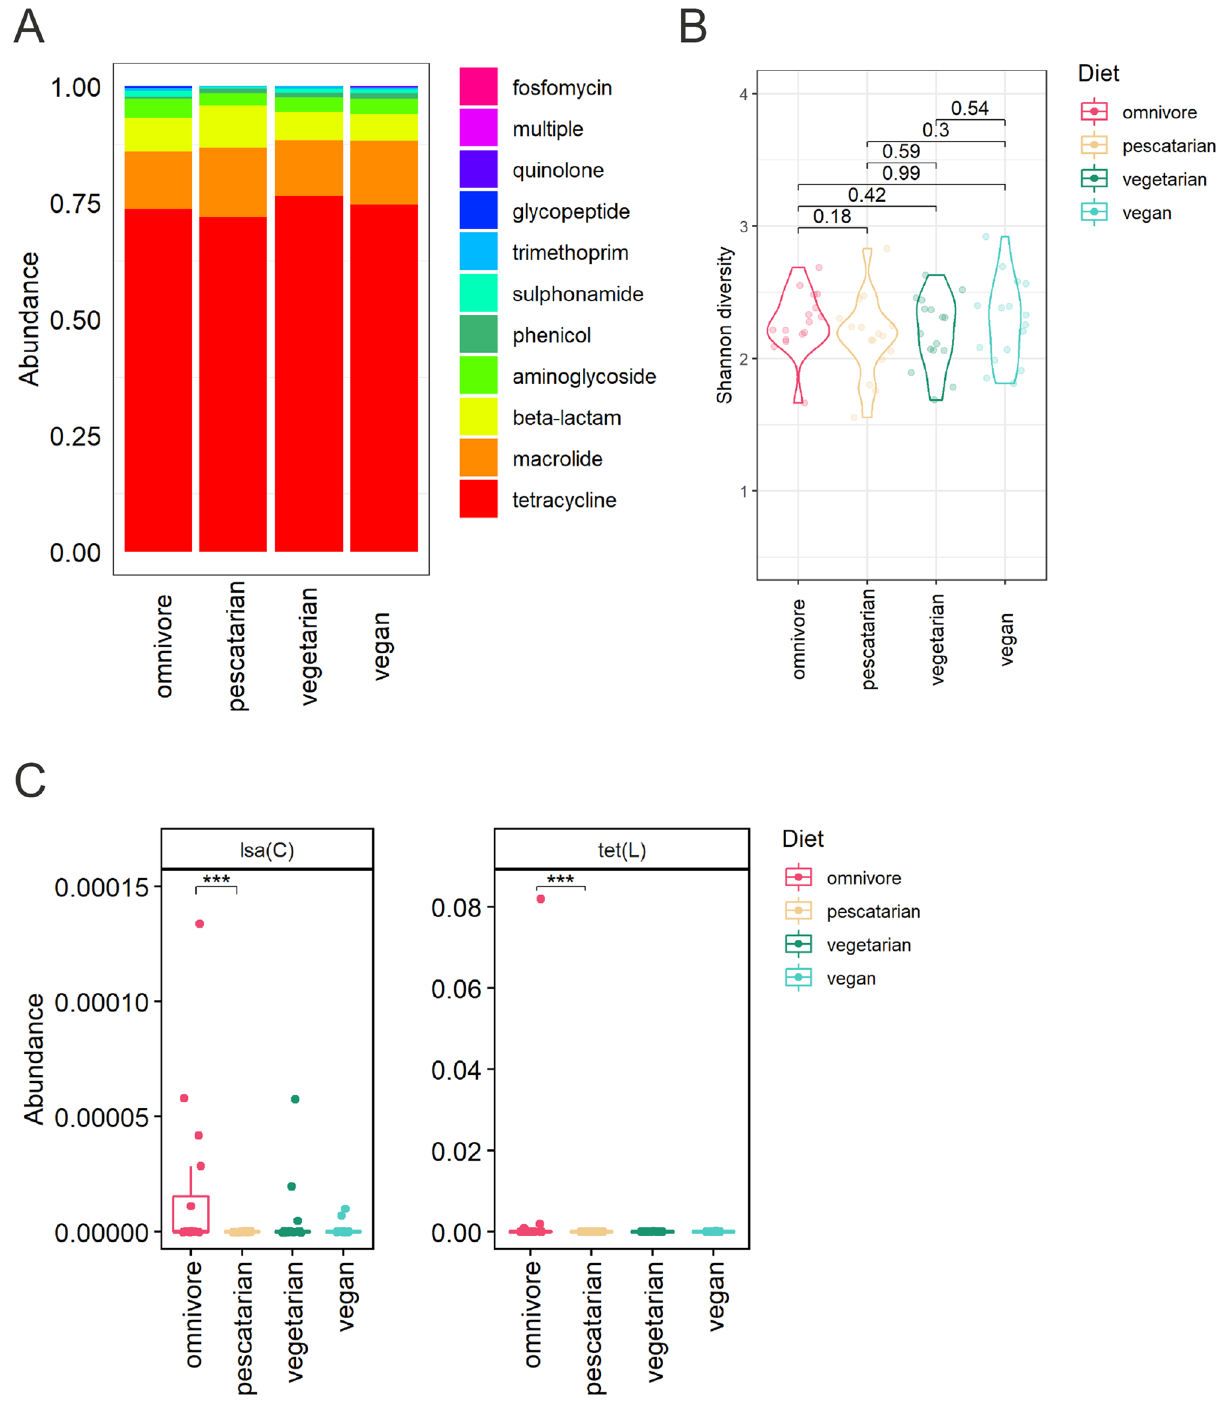
Figure 5. Association of dietary habits and the gut resistome composition through ResCap. ( A ) Relative abundance of the ten most abundant antibiotic resistance gene classes, summarized per diet group. ( B ) Gene diversity per diet group, shown by Shannon index. ( C ) Differential abundance analysis using ANCOM-BC plotted on the scale 0.00–1.00%. Adjusted p values below 0.001 are indicated by